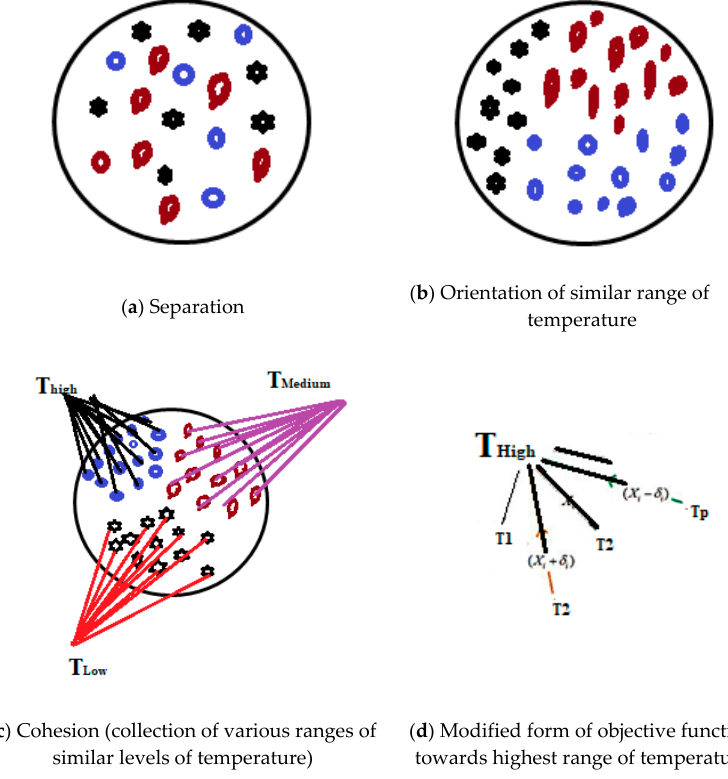
Figure 1. General concept of the DA algorithm in a PV system.